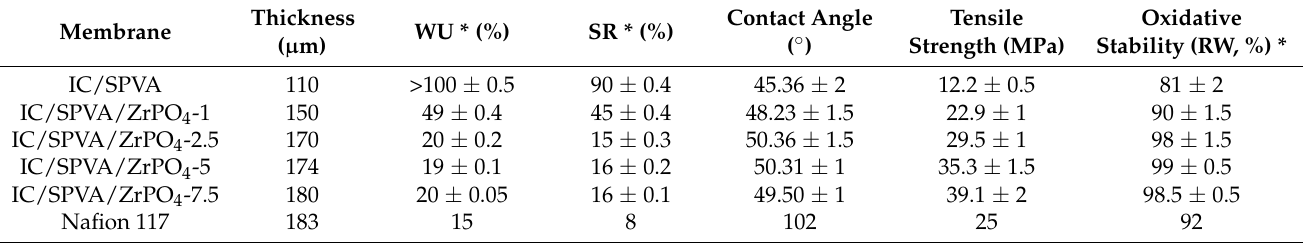
Table 1. Physicochemical properties of the membranes and Nafion